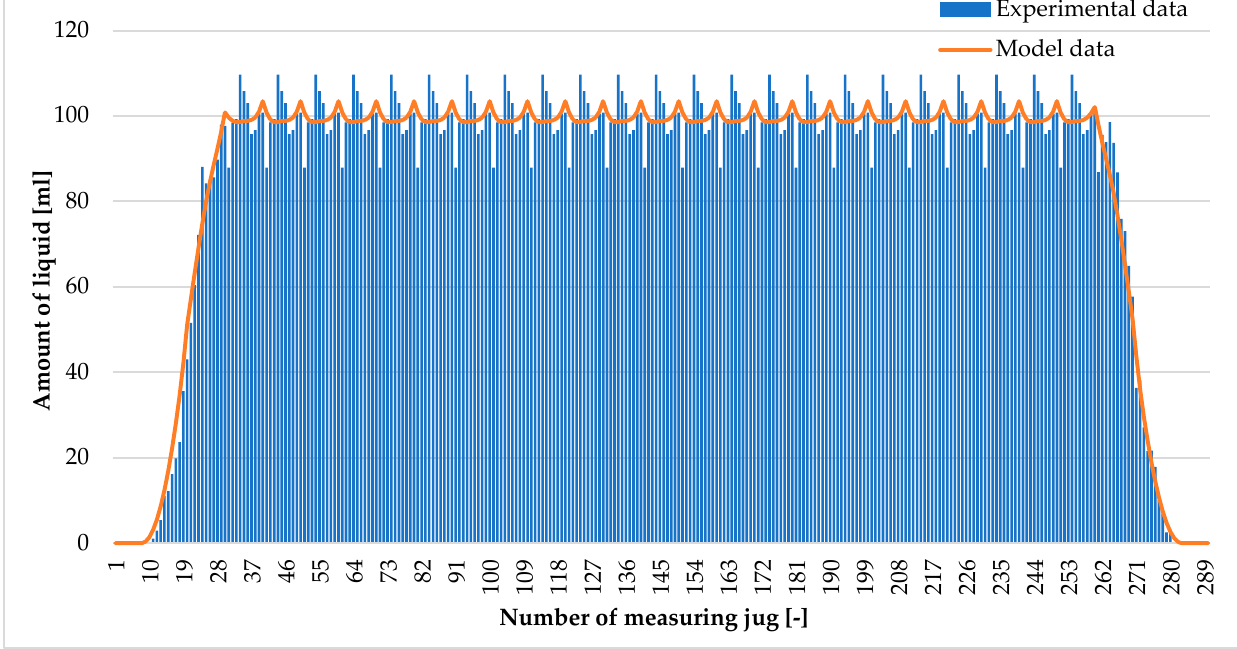
Figure 3. Spray fallout distribution for AZ MM 110 03 nozzles.